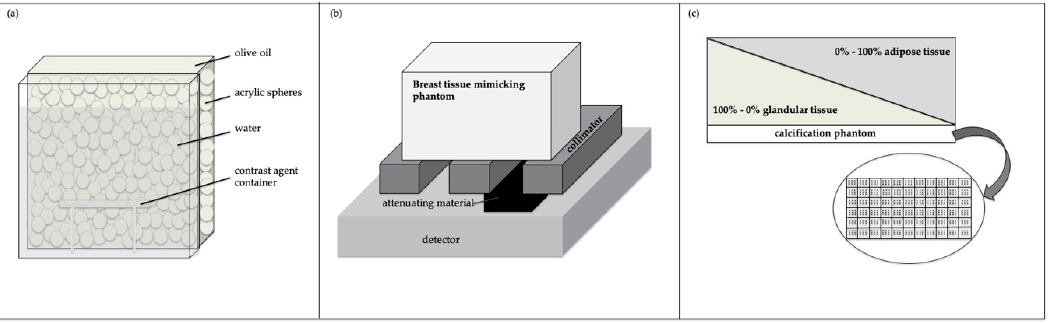
Figure 2. Schematic representation of the experimental studies’ phantoms [8,9,24,29]; ( a ) iodine concentration for dual energy contrast enhanced mammography technique; ( b , c ) calcification for dual energy mammography technique.